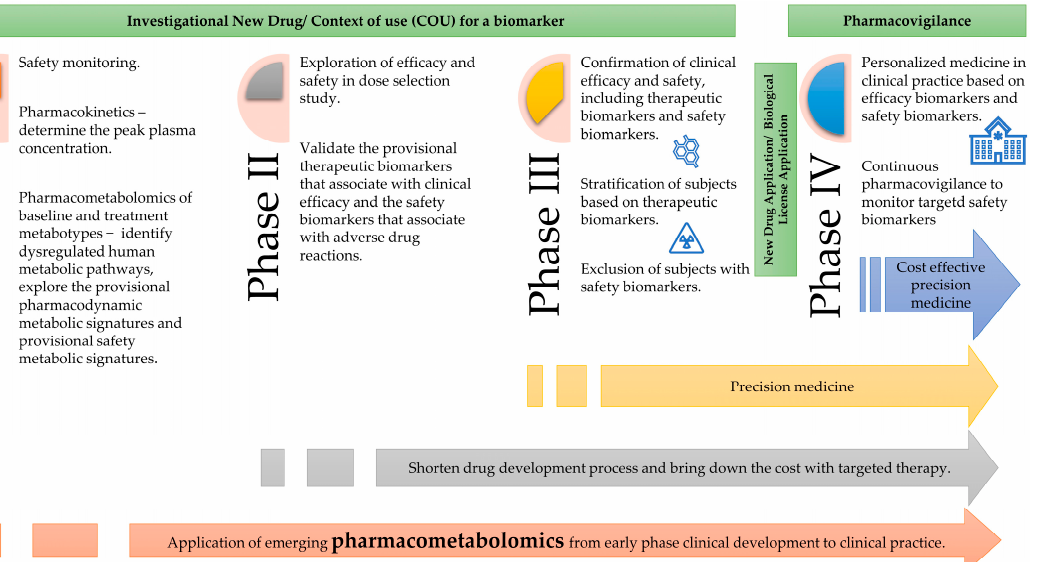
Figure 6. Model for application of pharmacometabolomics in clinical drug development.